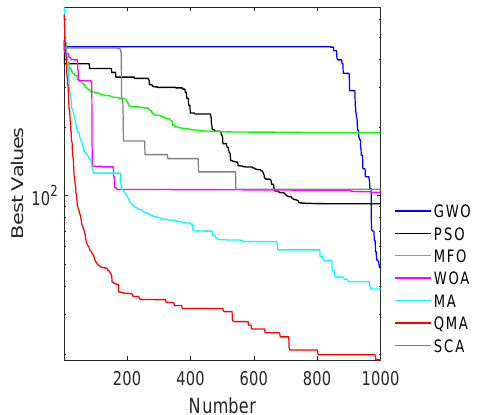
Figure 6. The optimization of algorithms using Rastrigrin